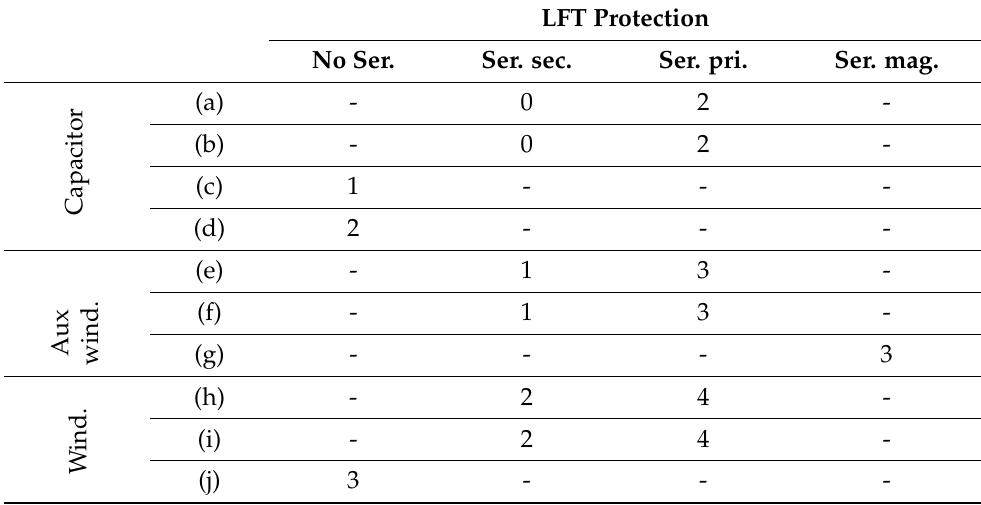
Table 5. Protection provided to the